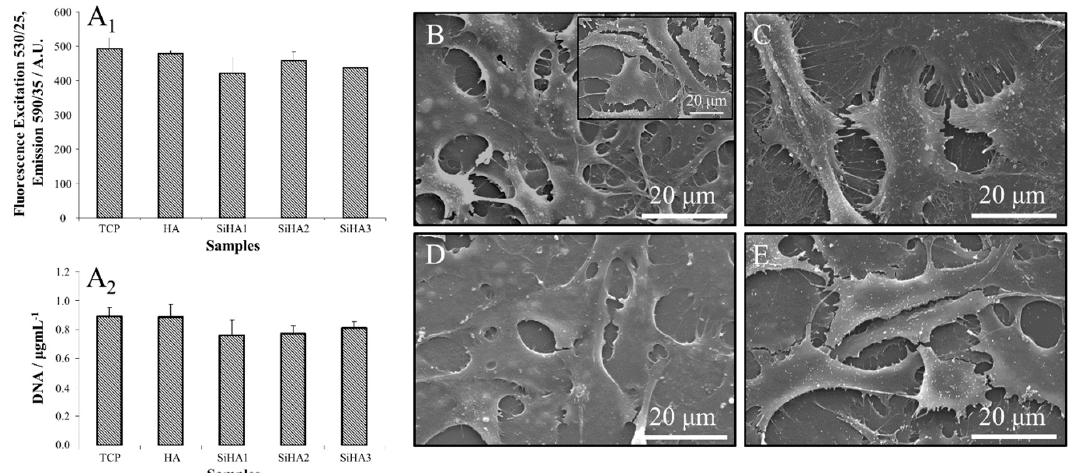
Figure 10. Combined elusion testing results showing: ( A 1 ) Metabolic activity and ( A 2 ) DNA content of pre-seeded HOB cells exposed to dissolution media of HA and SiHA samples for 24 h (Both expressed as mean ± standard error; n = 6); ( B – D ) SEM micrographs of HOB cell morphology on thermanox slides after 24 h of culture in media containing the dissolution products of ( B ) HA, ( C ) SiHA1, ( D ) SiHA2 and ( E ) SiHA3 thin films (insert image in B shows cells culture in fresh media for